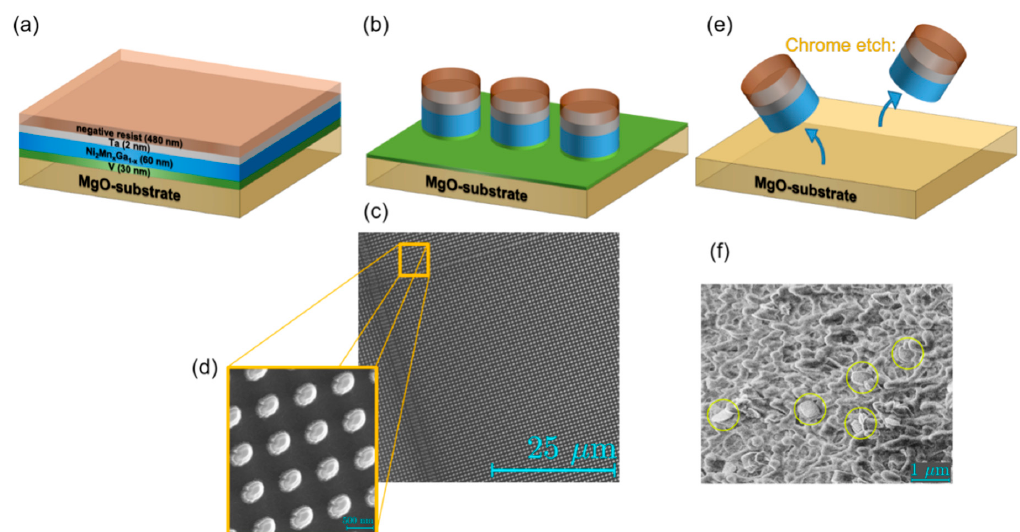
Figure 5. Complete workflow from the layer towards free Ni 50 Mn 32.5 Ga 17.5 Heusler particles [41]. ( a ) Layer structure with a two nm thick Ta-layer, which protects the Heusler layer from oxidation and the already applied resist layer; ( b ) Multilayered pillars just before etching; ( c ) Scanning electron microscope (SEM) image of these pillars enlarged in ( d ); ( e ) Etching of the V-layer of each pillar and releasing them from the substrate; ( f ) REM image of the filter paper with particles (circled in yellow).